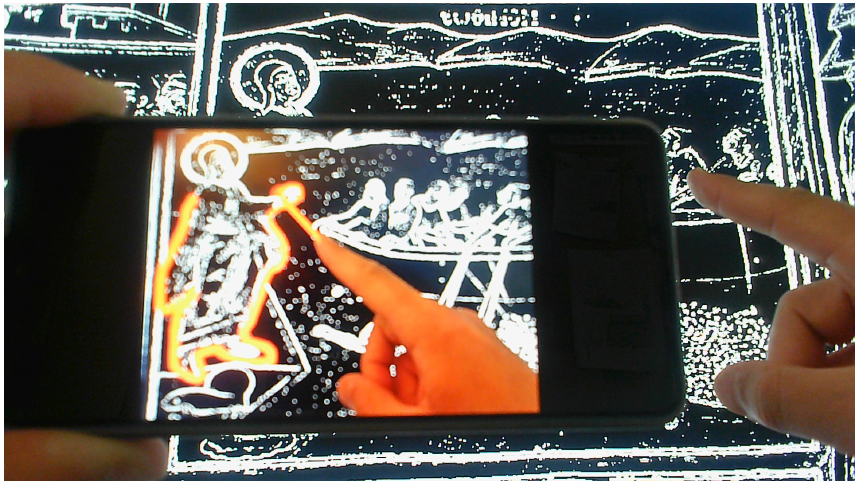
Figure 2. Interaction method: (ii) pointing recognition with